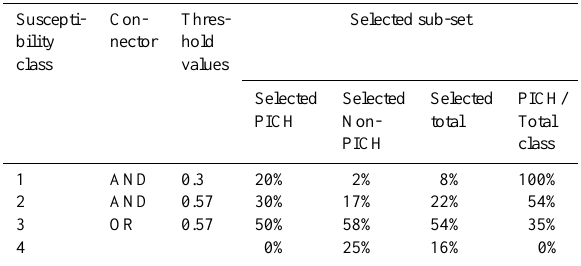
Table 6. Sorting efficiency based on the proposed indicator combination.